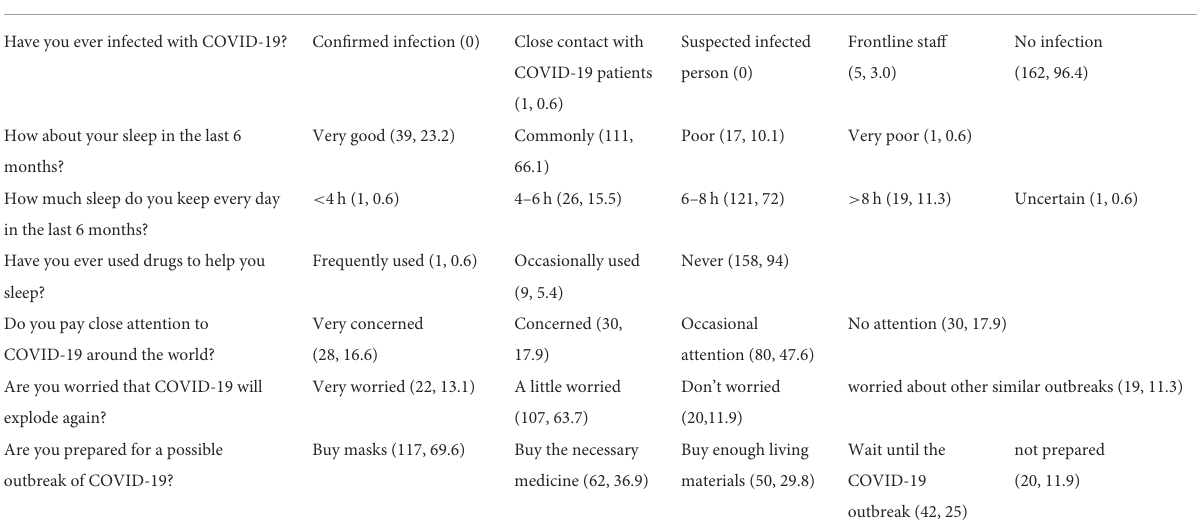
TABLE 3 Behavior response to COVID-19 outbreak after 8 months.